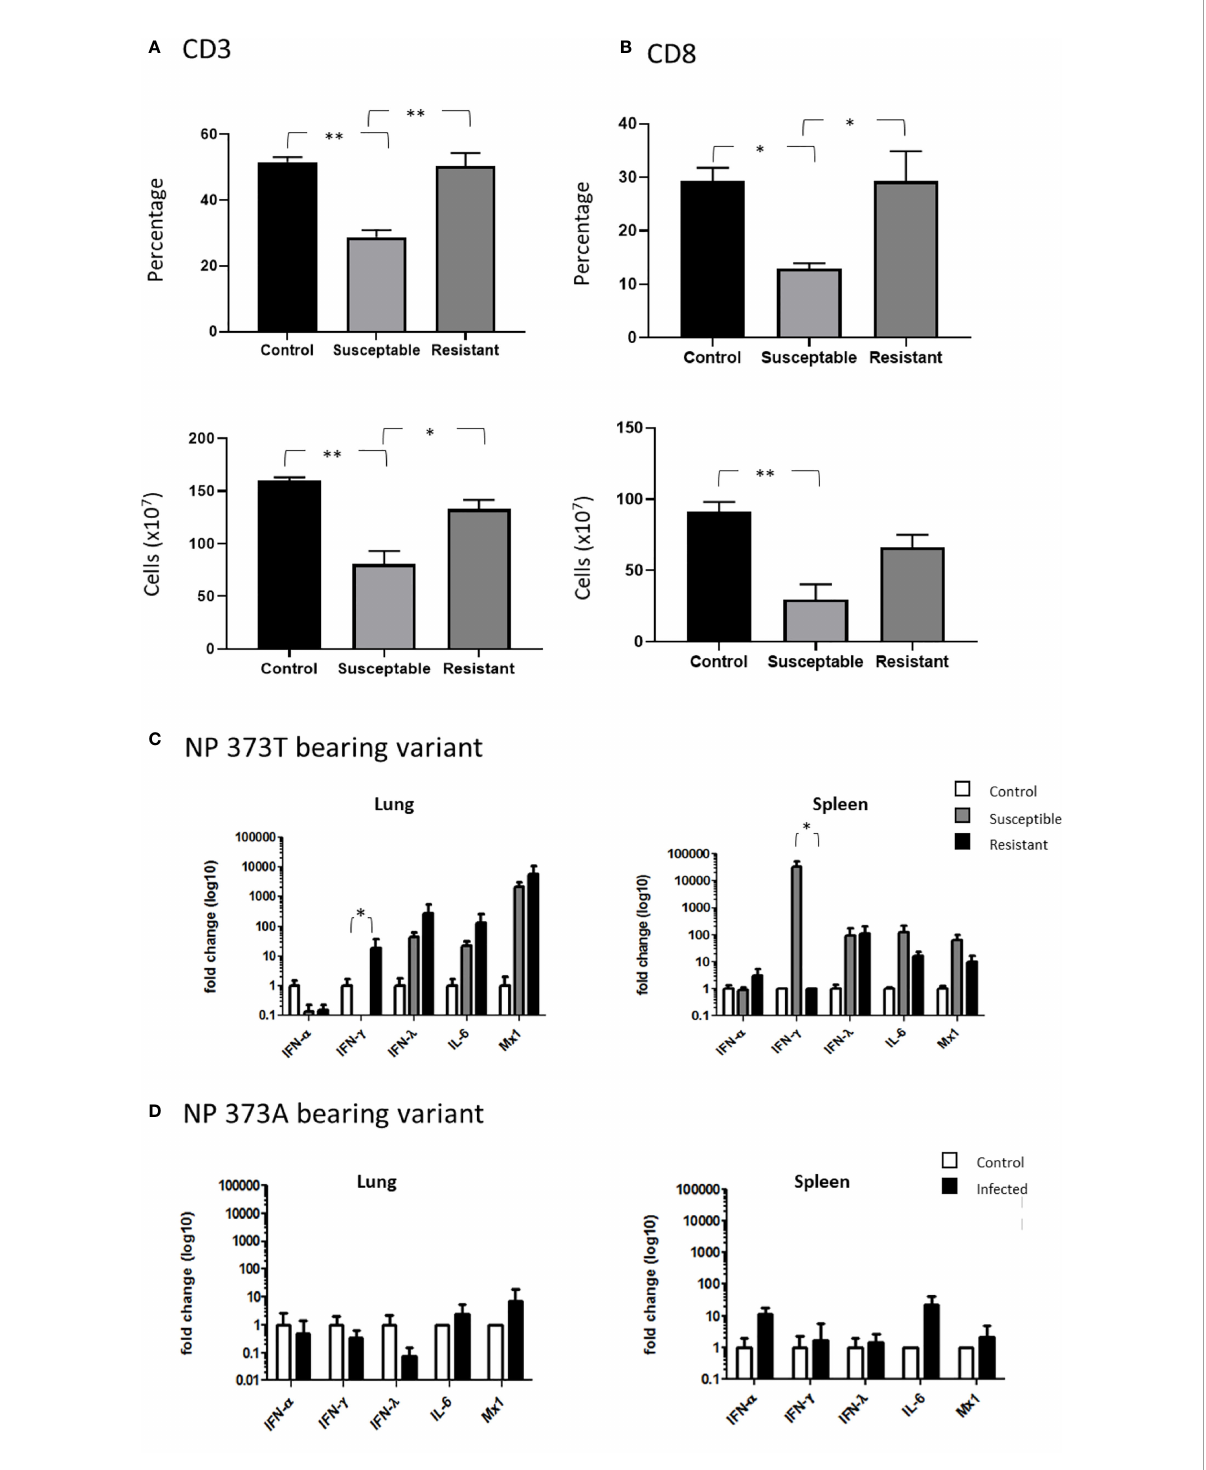
FIGURE 6 Severe disease is associated with severe CD8 + T cell depletion. Flow cytometry analysis of the proportions of (A) CD3 + T cells and (B) CD8 + cells comparing healthy uninfected control chickens to susceptible and resistant chickens. Cytokine expression analysis as determined by qPCR, in the lung and spleen of chickens infected with the (C) NP 373T bearing variant of A/Anhui/1/13 (H7N9) compared chickens infected with the (D) NP 373A bearing variant of A/Anhui/1/13 (H7N9). Error bars represent SEM. *p<0.05,